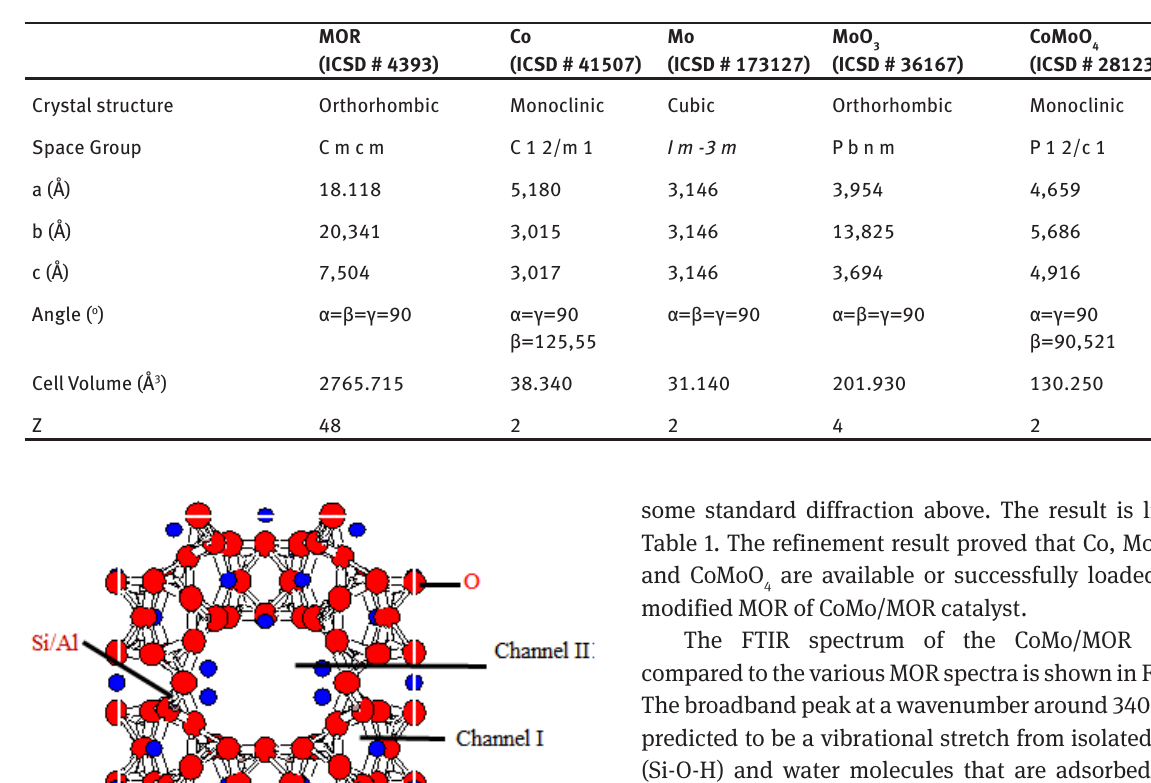
Table 1: The refinement result of P-XRD data of CoMo/MOR